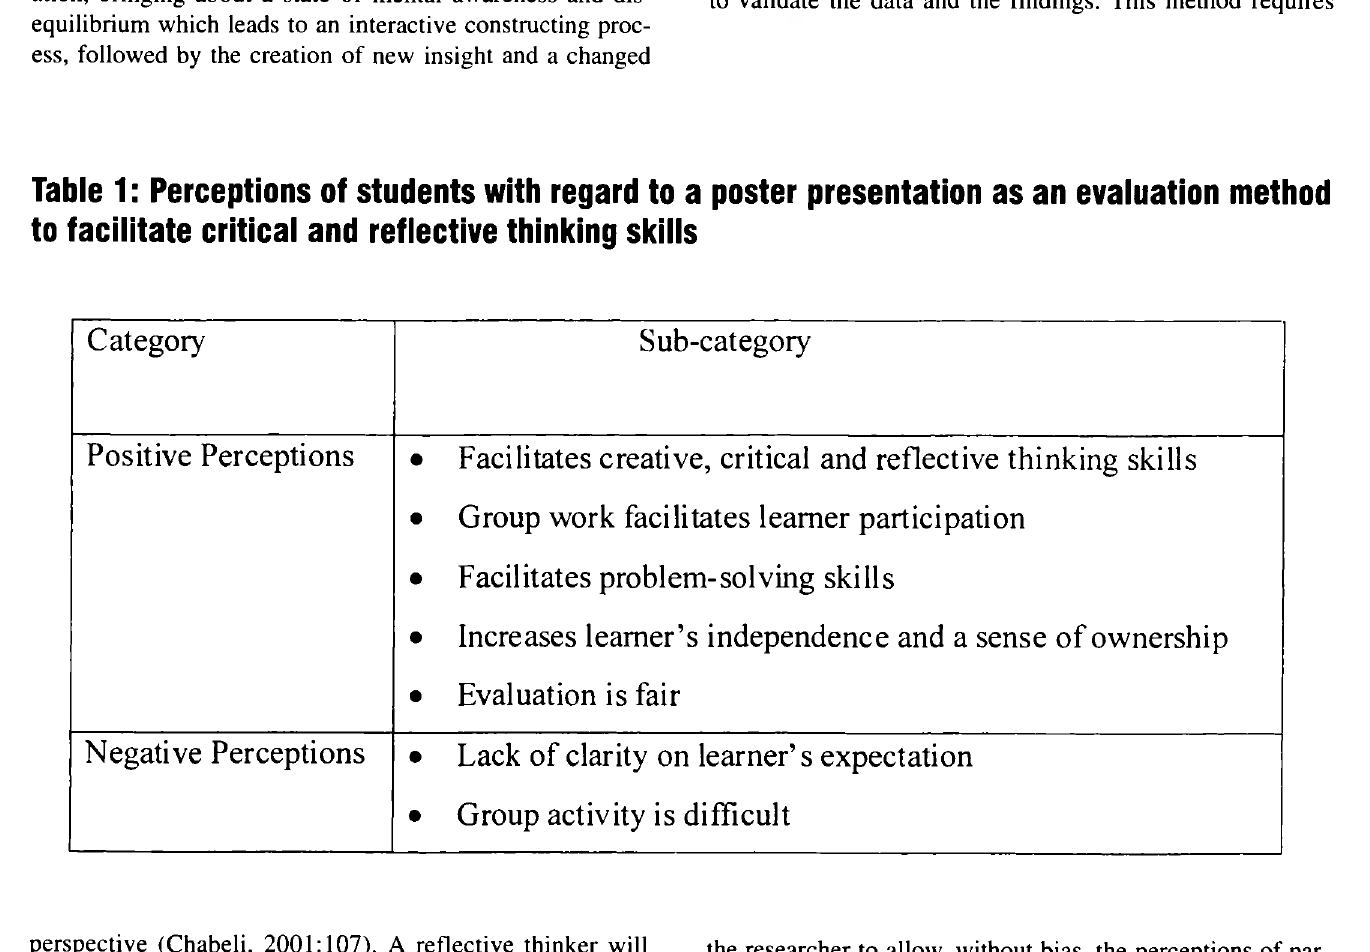
Table 1 : Perceptions of students with regard to a poster presentation as an evaluation method to facilitate critical and reflective thinking